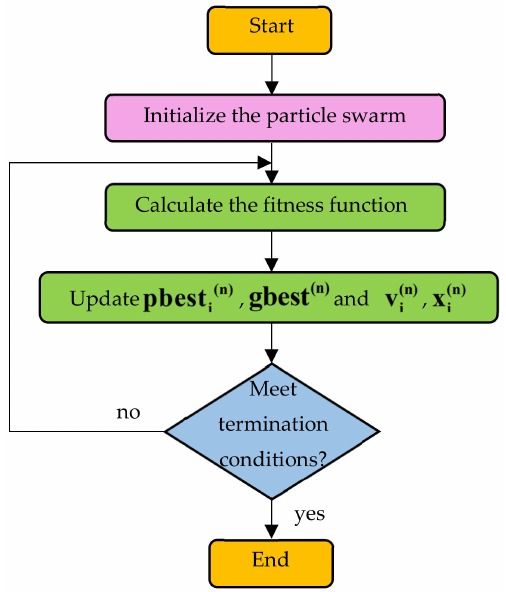
Figure 4. Flow chart of particle swarm optimization